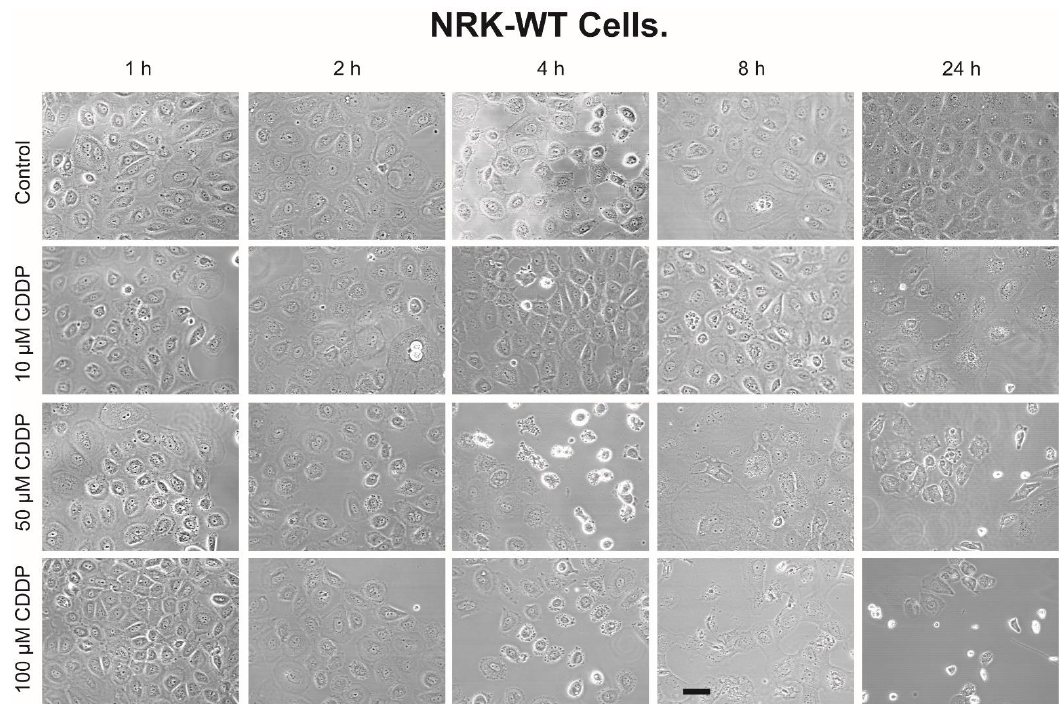
Figure 3. Morphology of NRK-52E-WT cells incubated with CDDP. Confluent, wild-type NRK-52E cells (NRK-52E-WT) were incubated for up to 24 h with 0, 10, 50, or 100 µ M CDDP. Photomicrographs were obtained on a Zeiss Triple Laser-Scanning confocal microscope at an initial magnification of 196 × . Bar = 5 µ m.